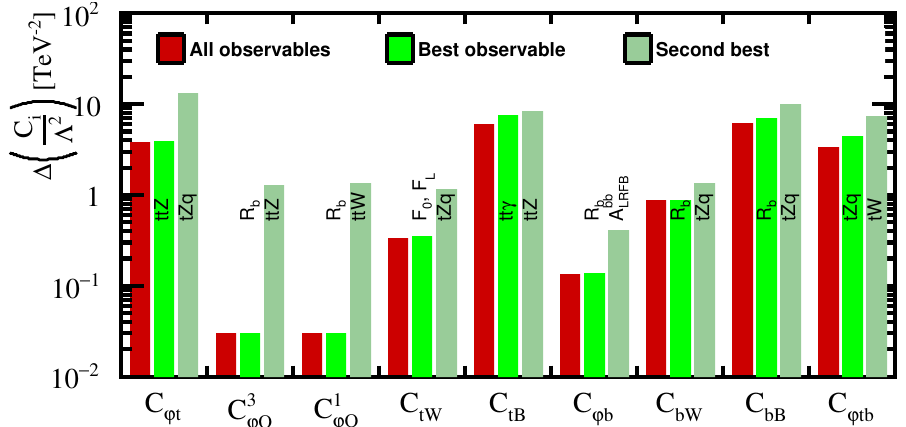
Figure 1 . Results of single-parameter individual (cid:12)ts to the Wilson coe(cid:14)cients of the dimension-six operators introduced in section 2. For each operator the 1 (cid:27) uncertainty is shown. The three bars respectively correspond to the result of the combined (cid:12)t using all data (red), to the constraint obtained from the most sensitive single measurement (light green), and to that of the second-best measurement (greyish